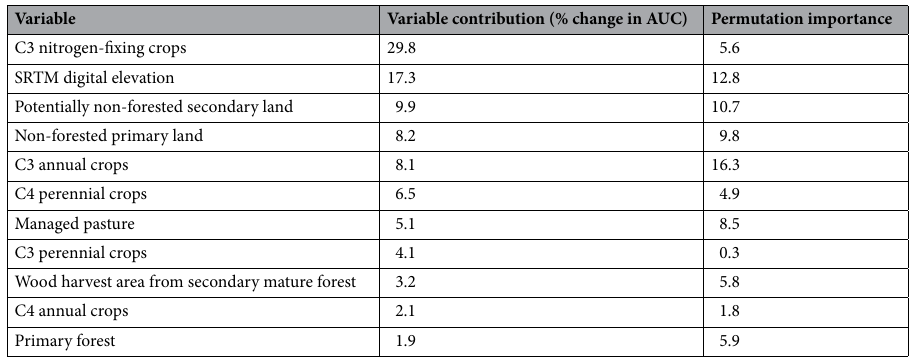
Table 1. LUH2 predictors with relative contributions > 1%. Variables are ordered from most to least influential, noting that their contribution can be driven by either positive or negative associations. See Table 4 in methods for complete list of